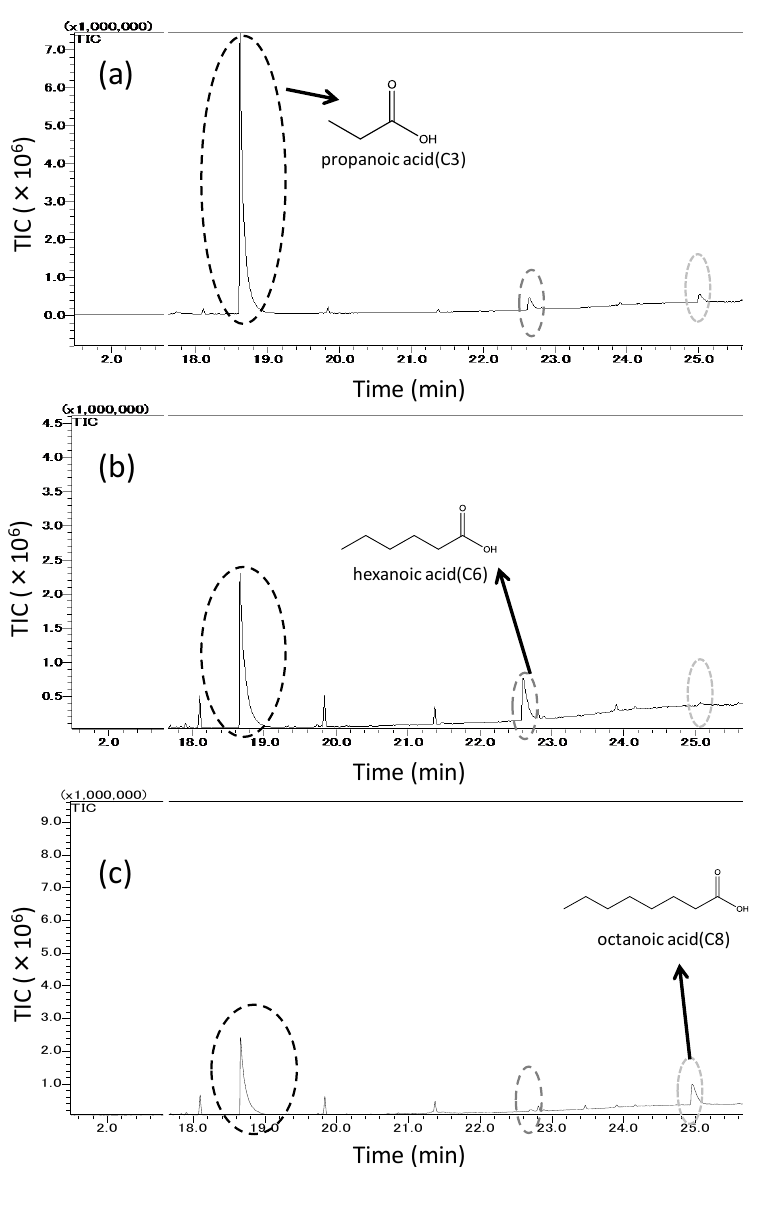
Figure 7. Chromatograms from 18 min to 26 min, comparison of ( a ) untreated PDMS, ( b ) MIFA , and ( c ) MIFA to fatty hexanoic acid octanoic acid